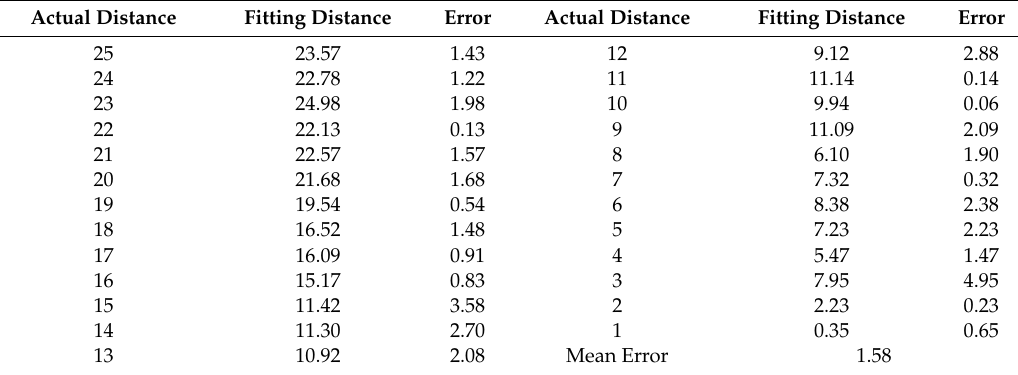
Table 1. The errors between each point and the fitting point after the first fitting in meters.